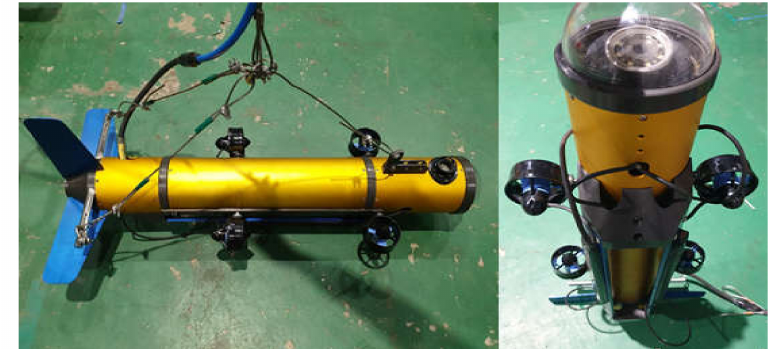
Figure 6. Photographs of assembled